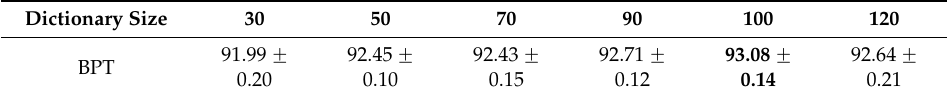
Table 5. Classification results under different dictionary sizes on the UCM